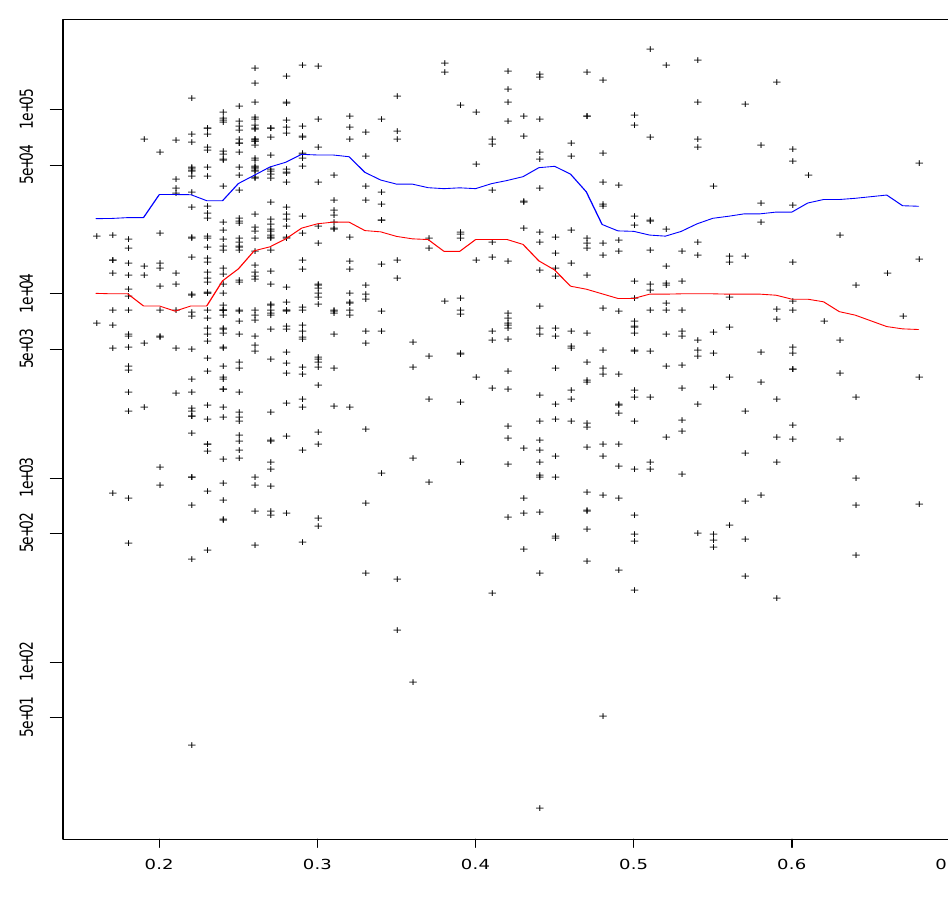
Figure 4: Illustration on motorcycle insurance data. Horizontally: Age of the policyholder (hundred of years), vertically: Claim severity (SEK, log scale). Data ( + ), estimated location function ˆ a